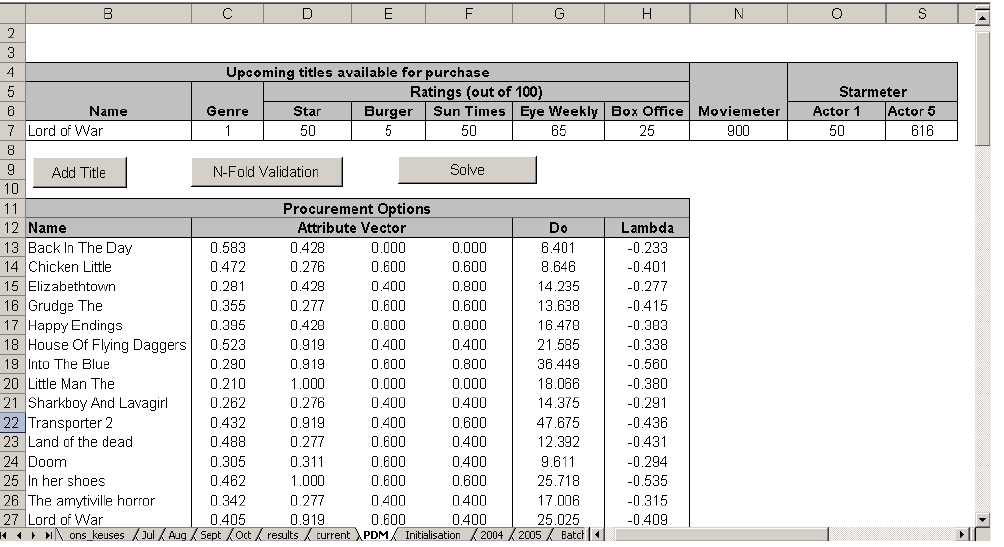
Figure 2: Spreadsheet implementation of PDM (Stage